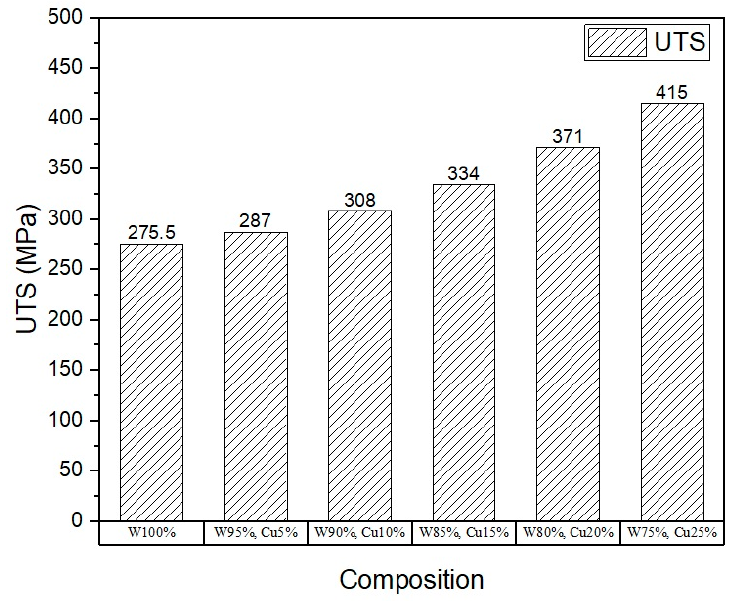
Figure 5. Plot of ultimate tensile strength.